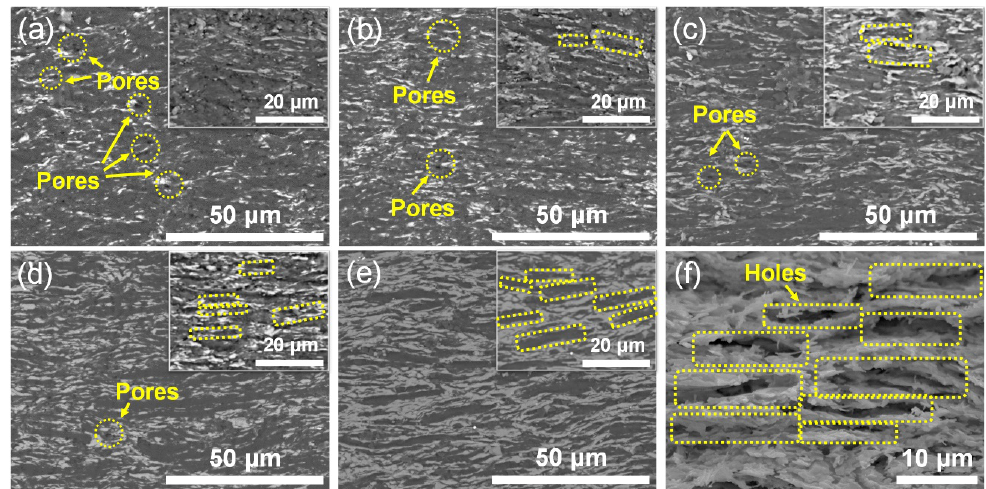
Fig. 4 BEIs of polished surfaces (parallel to z axis direction) of (a) SiC15/GF, (b) SiC20/GF, (c) SiC25/GF, (d) SiC30/GF, and (e) SiC50/GF composites, where the insets in (a–e) are the magnified images corresponding to the polished surfaces. (f) Microstructure of the decarbonized SiC20/GF composite.